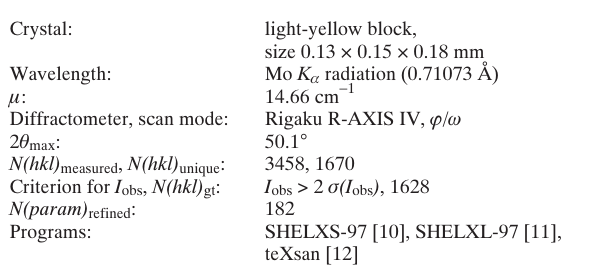
Table 1. Data collection and